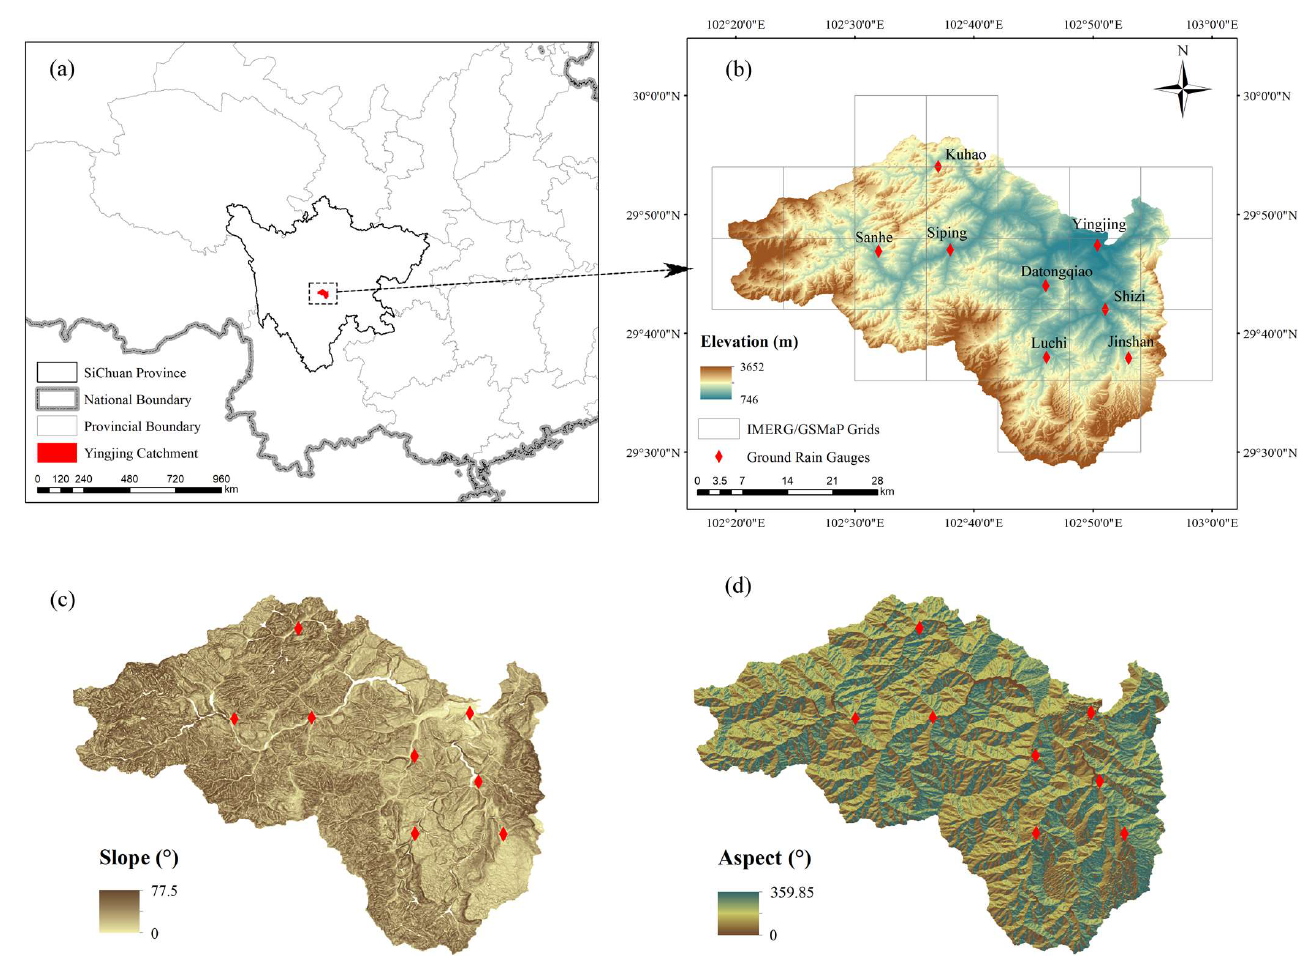
Figure 1. Map of Yingjing catchment ( a , b ). The slope ( c ) and aspect ( d ) distribution of this catchment.